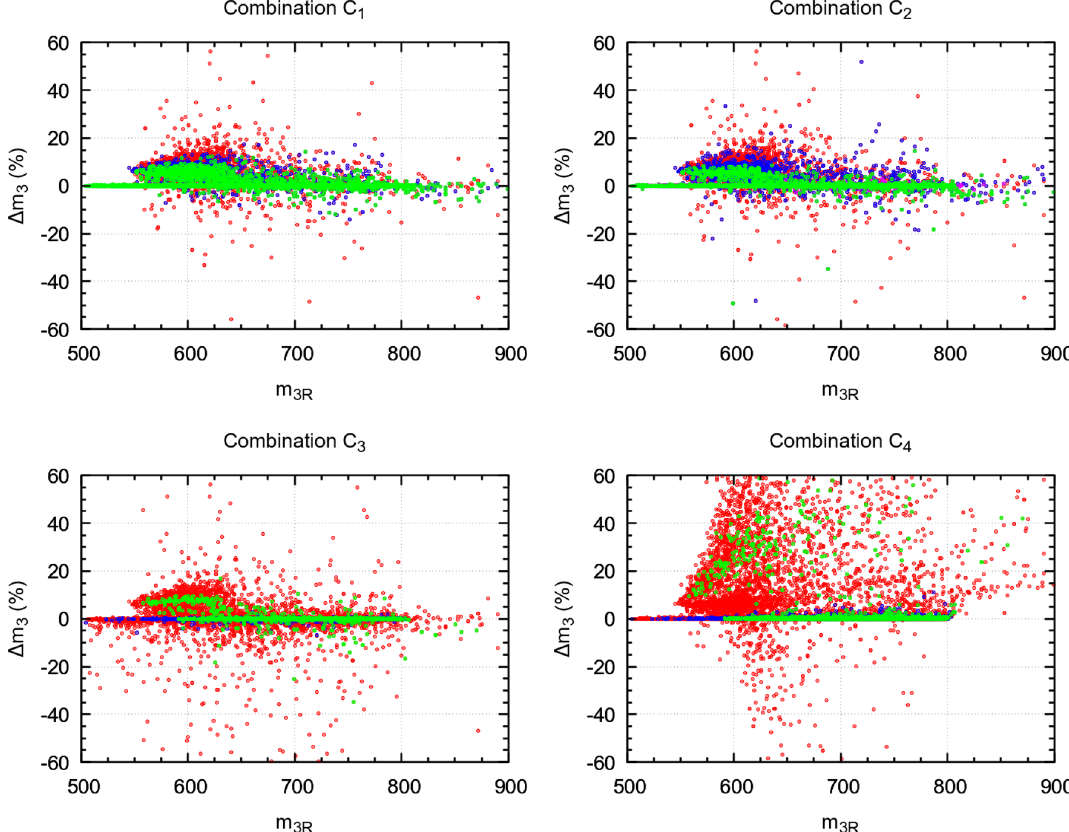
Figure 3. The same as in figure 1, but with extra cuts: in C 1 , blue points have π/ 2 −| α 3 | > 0 . 0005 and | α 3 | > 0 . 0005 , whereas green points have π/ 2 − | α 3 | > 0 . 0007 and | α 3 | > 0 . 00085 ; in C 2 , blue points have π/ 2 −| α 3 | > 0 . 0005 and | α 3 | > 0 . 0005 , whereas green points have π/ 2 −| α 3 | > 0 . 00075 , | α 3 | > 0 . 001075 and | α 2 | > 0 . 001 ; in C 3 , blue points have π/ 2 −| α 3 | > 0 . 005 , | α 3 | > 0 . 05 and | α 2 |